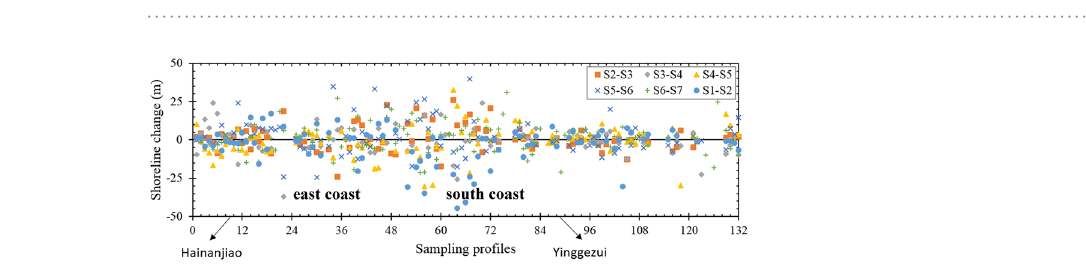
Table 1. Dates of the seven surveys and the meteorological data of the storms that affected Hainan Island during the surveys. The meteorological data were acquired from the Regional Specialized Meteorological Center (RSMC) Tokyo-Typhoon Center (http://www.jma.go.jp/jma/indexe.html). The categories of tropical cyclone intensities are designated by the Japan Meteorological Agency: Grade 3 is a tropical storm, Grade 4 is a severe tropical storm, and Grade 5 is a typhoon.